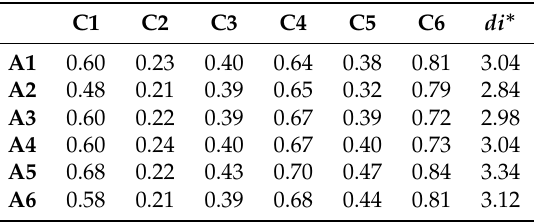
Table 11. Distance of